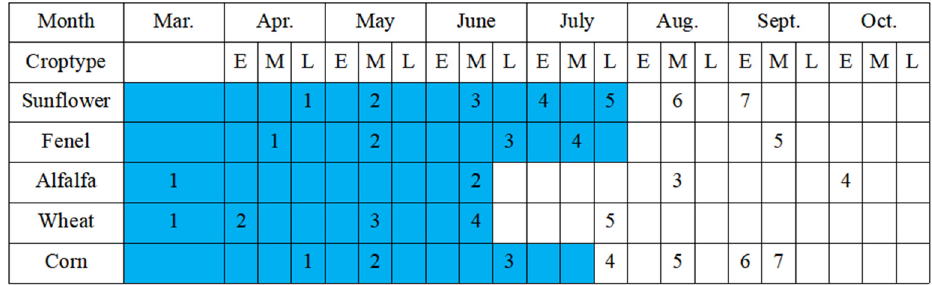
Figure 9. Earliest identification times on the crop calendar for the Shiyang River Basin. The blue cells indicate that Sentinel-2 time-series data were needed to identify each crop in the early growing season. E, M, and L indicate the early, middle, and late parts of the month. Sunflower: 1-Sowing, 2-